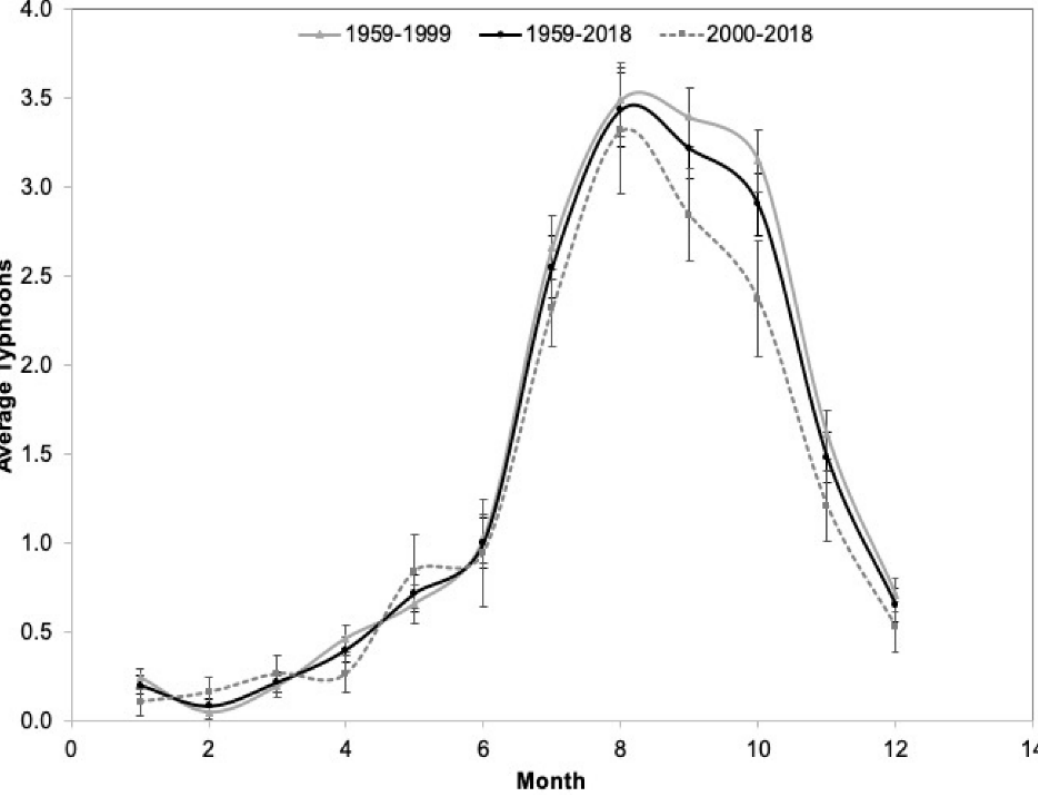
Figure 3. Average number of typhoons ( ≥ 64 knots) by month for three different periods of time (1959–1999, 1959–2018, and 2000–2018), showing that the numbers of typhoons by month have decreased. Standard error bars are shown for the average number of typhoons for the 1959–2018 line.